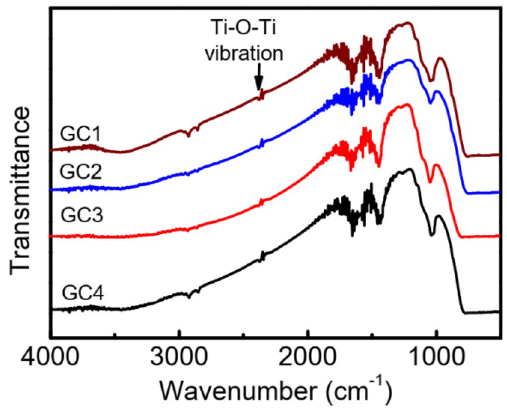
Fig. 6 FT-IR spectra of the prepared LTO material